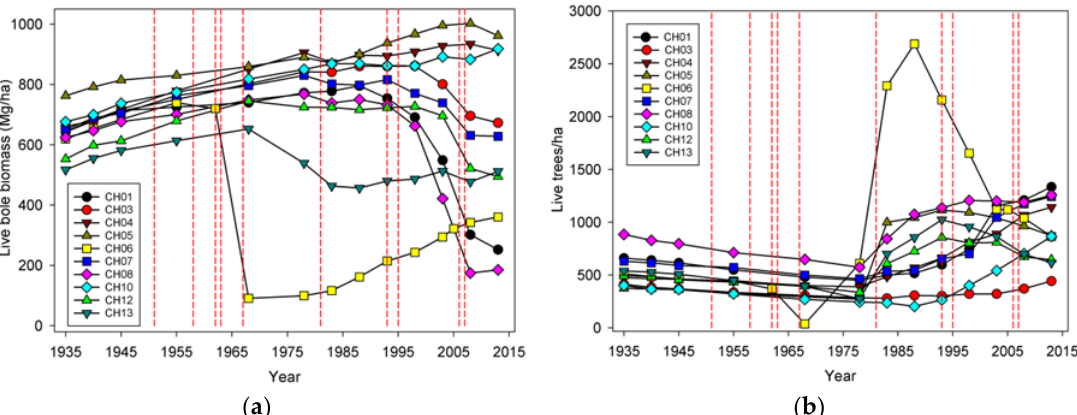
Figure 4. Long-term trends in bole biomass (Mg) per hectare ( a ) and number of trees per hectare ( b ) in each of the ten permanent plots at Cascade Head Experimental Forest, Otis, OR, USA. The red vertical lines indicate major wind events.